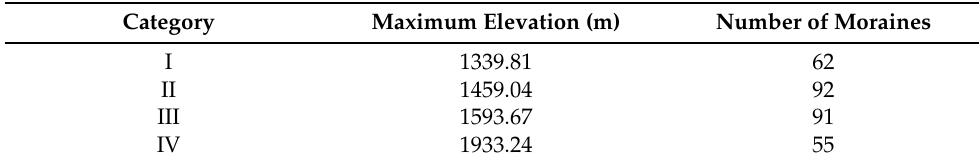
Table 2. General elevational moraine distribution using Jenks’s method.